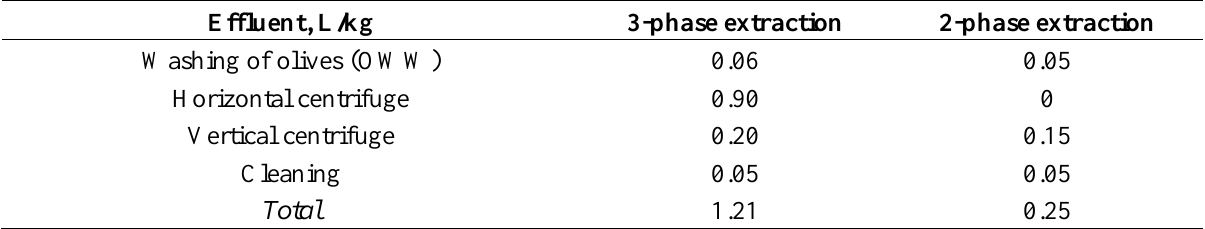
Table 2. Effluents flowrates of continuous olive oil extraction processes